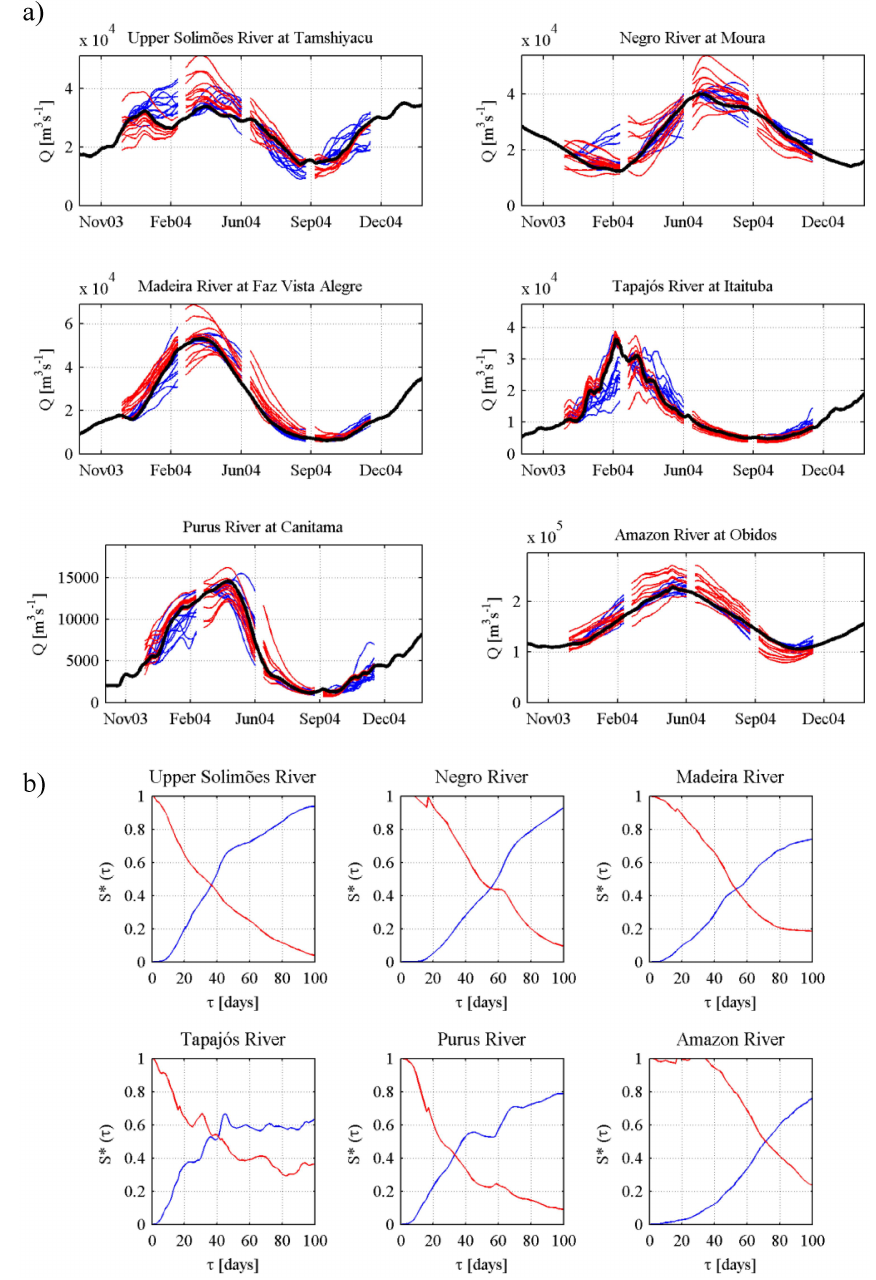
Fig. 3. Retrospective simulation (black), ESP (blue) and reverse-ESP (red) (a) discharge results and (b) relative ensemble spread S ∗ ( τ ) as function of the lead time τ . Results are presented at upper Solim˜oes (Sol), Negro (Neg), Madeira (Mad), Tapaj´os (Tap), Purus (Pur) and Amazon (Am) Rivers at sites shown in Fig.